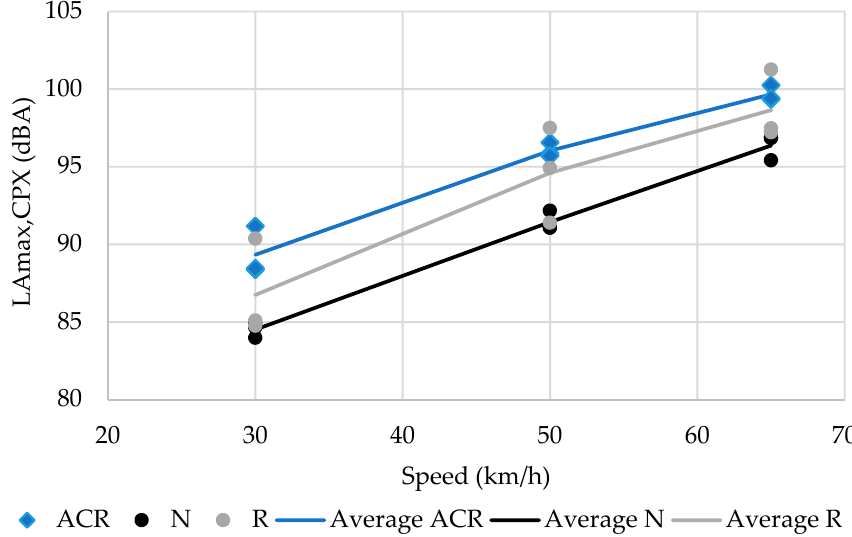
Figure 5. L A max,CPX of all pavement types by distress type.